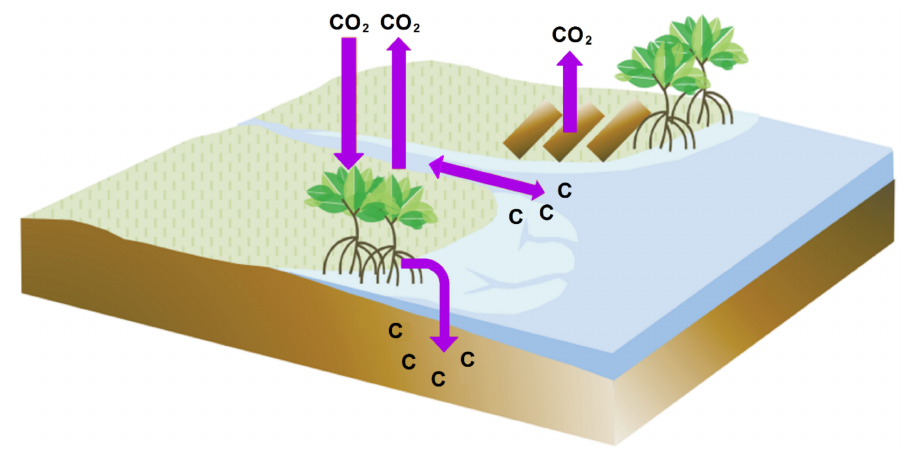
Figure 1. Major carbon flux pathways in mangrove forests. Modified from http://